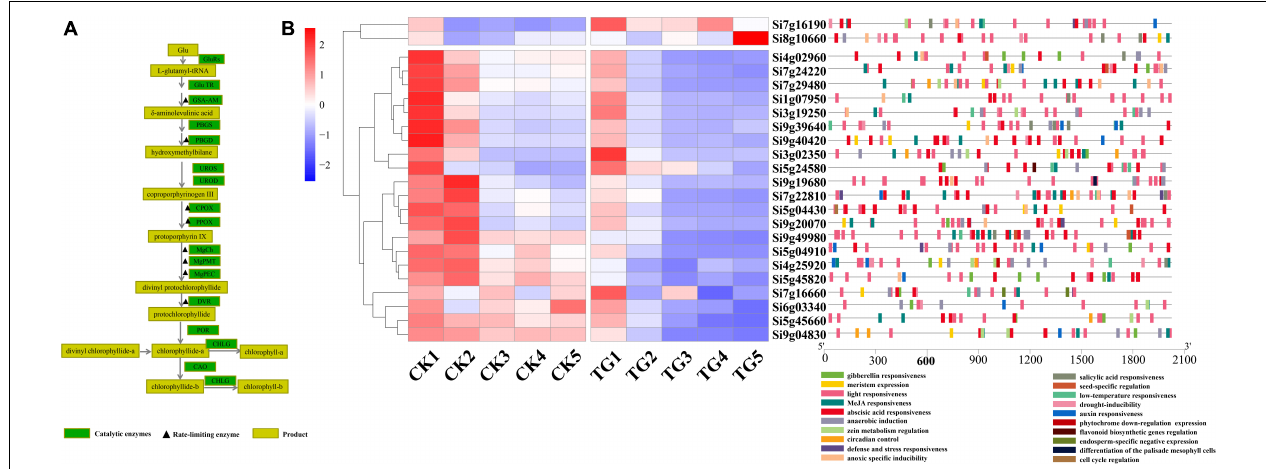
FIGURE 7 | Analysis of expression of genes related to chlorophyll biosynthesis. (A) Chlorophyll synthesis pathway and related enzymes; (B) heat map and cis acting element analysis of genes related to chlorophyll synthesis at each stage.